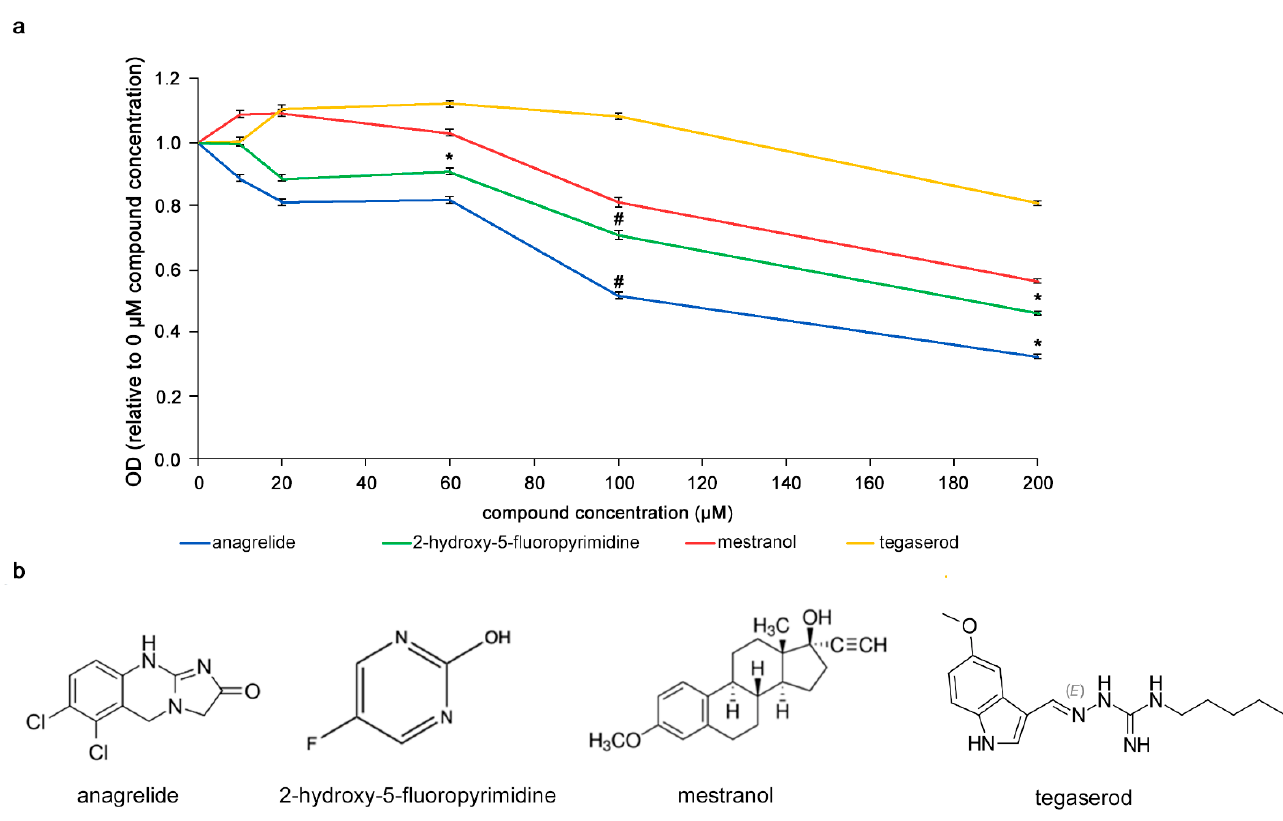
Figure 1. Competition ELISA with mimetics. ( a ) Concentration-dependent reduction of antibody 324 binding to substrate-coated L1-Fc by anagrelide, 2-hydroxy-5-fluoropyrimidine and mestranol. Tegaserod served as negative control. Compounds were incubated with antibody 324 and then tested for binding to substrate-coated mouse L1-Fc. Antibody binding to L1-Fc without compounds was set to 1 for absorbance/OD. Significance of differences between mimetics and tegaserod was determined by one-way ANOVA with Tukey’s post hoc test. * p < 0.05, # p < 0.01. The small error bars show mean ± SEM. ( b ) Chemical structure of mimetics and tegaserod.